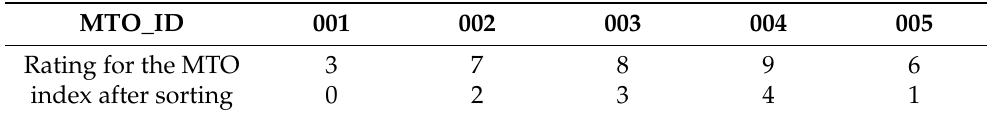
Table 1. Rating from a student for the